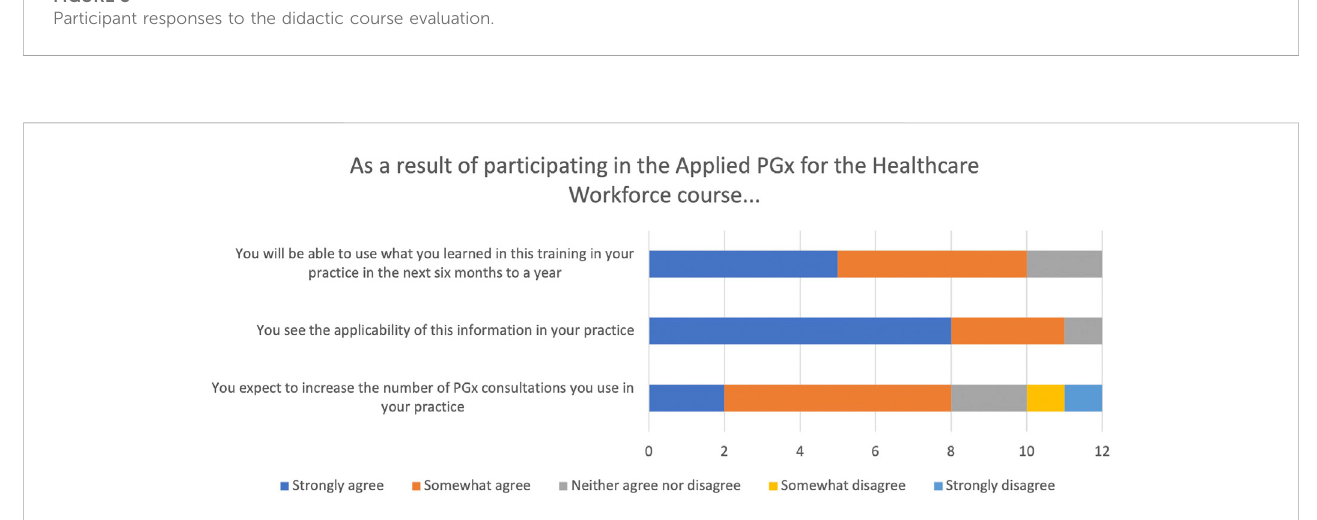
FIGURE 4 Participant responses relative to PGx practice after completing the didactic